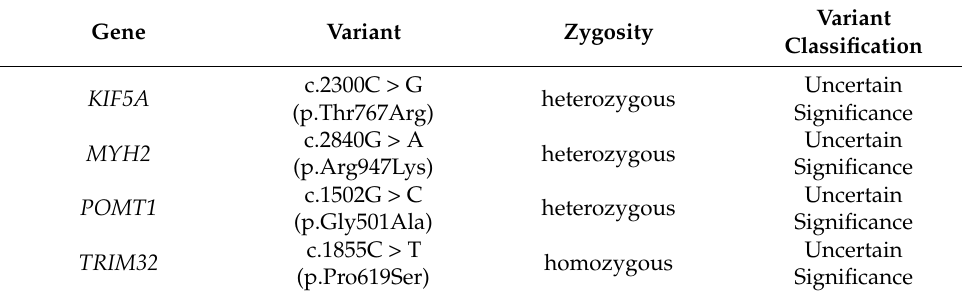
Table 1. Identified variants of uncertain significance.